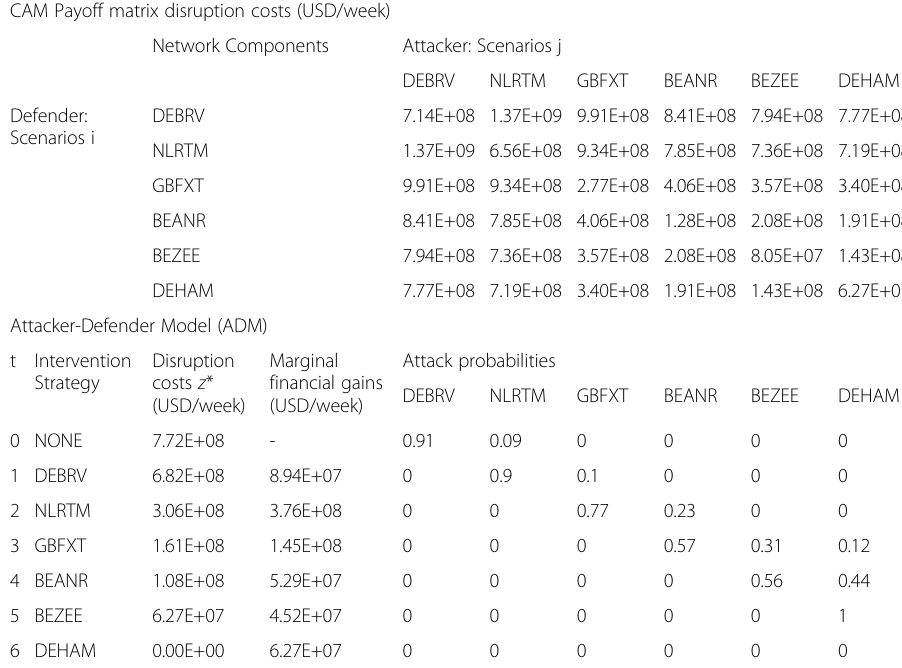
Table 4 CAM Payoff matrix disruption costs (USD/week) Network Components Attacker: Scenarios j